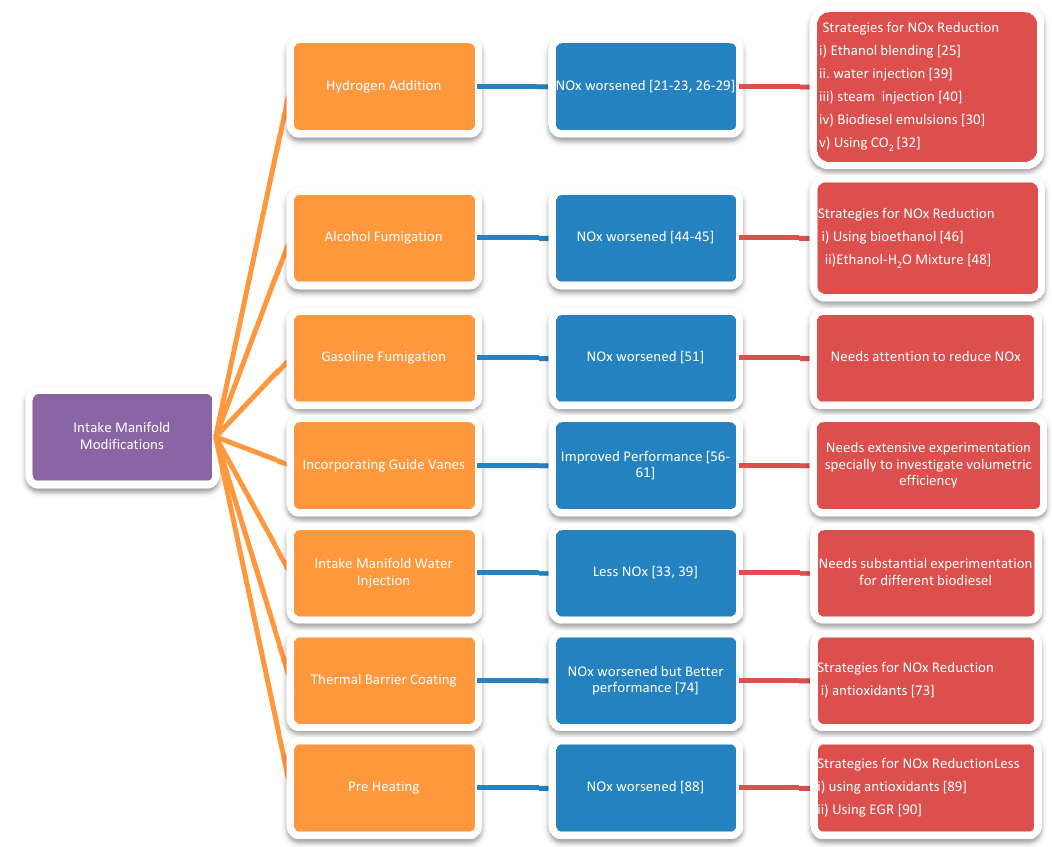
Figure 4. Schematic diagram of intake manifold modifications.